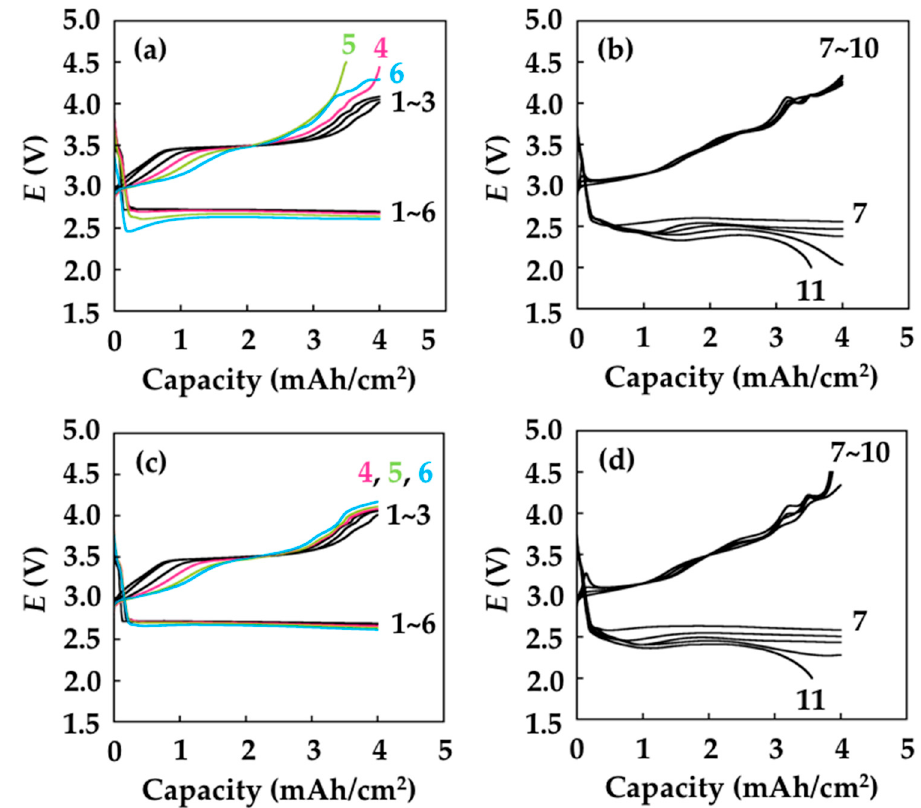
Figure 7. Discharge/charge performance of LOBs. ( a ) Cycles 1–6 and ( b ) cycles 7–11 for the LOB equipped with the PE separator. ( c ) Cycles 1–6 and ( d ) cycles 7–11 for the LOB equipped with the LICGC/PEO/LiTFSI-PE separator.